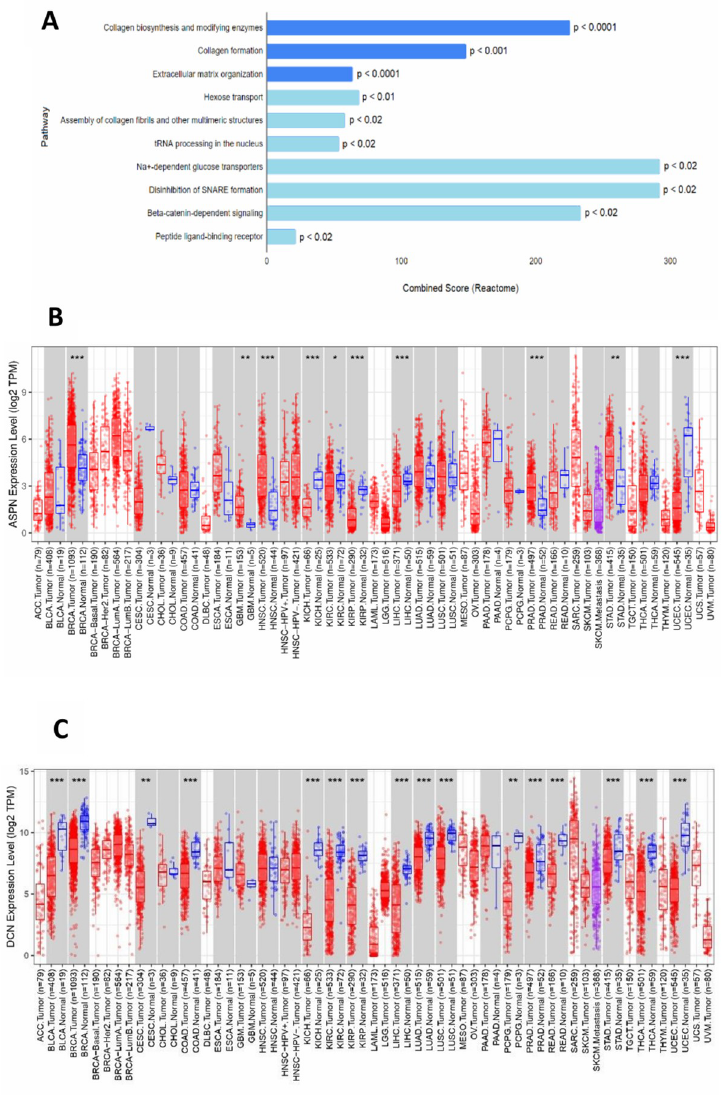
Fig 1. Transcriptomic data analysis of TCGA-STAD cohort. (A) Reactome Analysis of genes that showed stage-wise upregulation in GC on TCGA-STAD data. (B, C) The differential expression between tumor and adjacent normal tissues for ASPN (B) and DCN (C) across all TCGA tumors. Distributions of gene expression levels are displayed using box plots. The statistical significance computed by differential analysis (edgeR) on RNA-Seq raw counts is annotated by � p � 0.05, �� p � 0.01, ��� p � 0.001. Up-regulated or down-regulated in the tumors compared to normal tissues for each cancer type are displayed in grey columns when normal data are